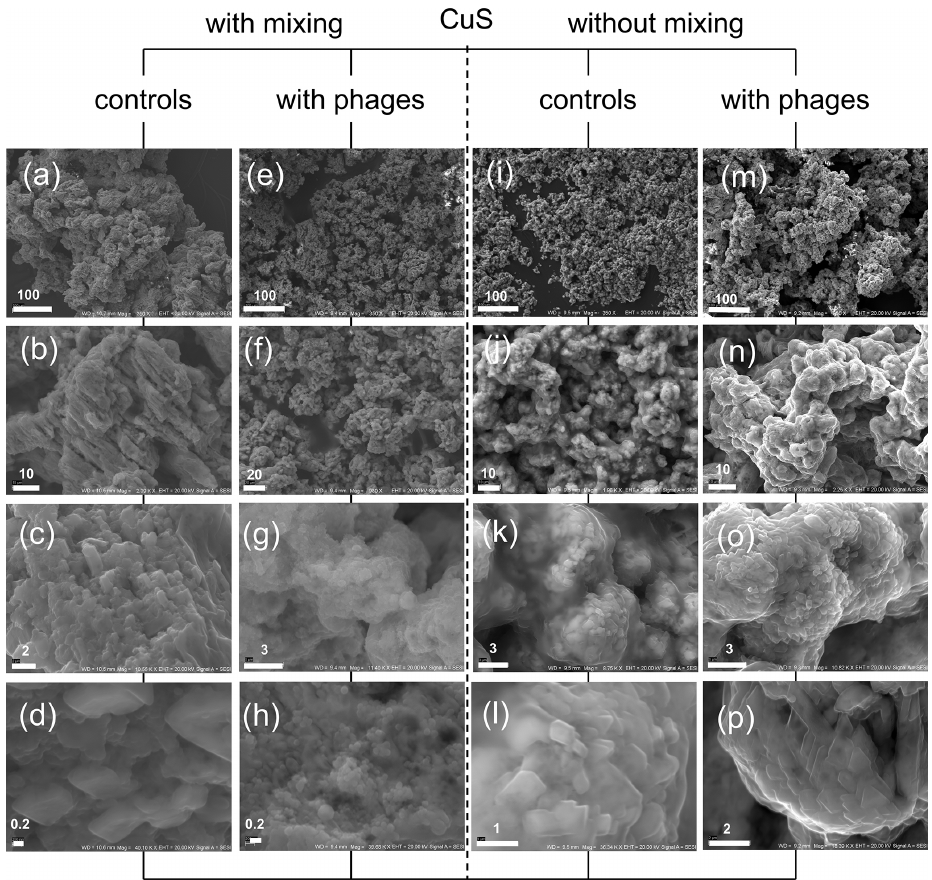
Figure 8. CuS minerals under SEM after experiments with and without P1 bacteriophage. (a–d) Mineral structures precipitated without bacteriophages under mixing conditions; (e–h) minerals obtained in experiment with bacteriophages under mixing conditions; (i–l) minerals precipitated without bacteriophages under static (without mixing) conditions; (m–p) minerals precipitated with bacteriophages under static conditions. Bar indicates scale in micrometres